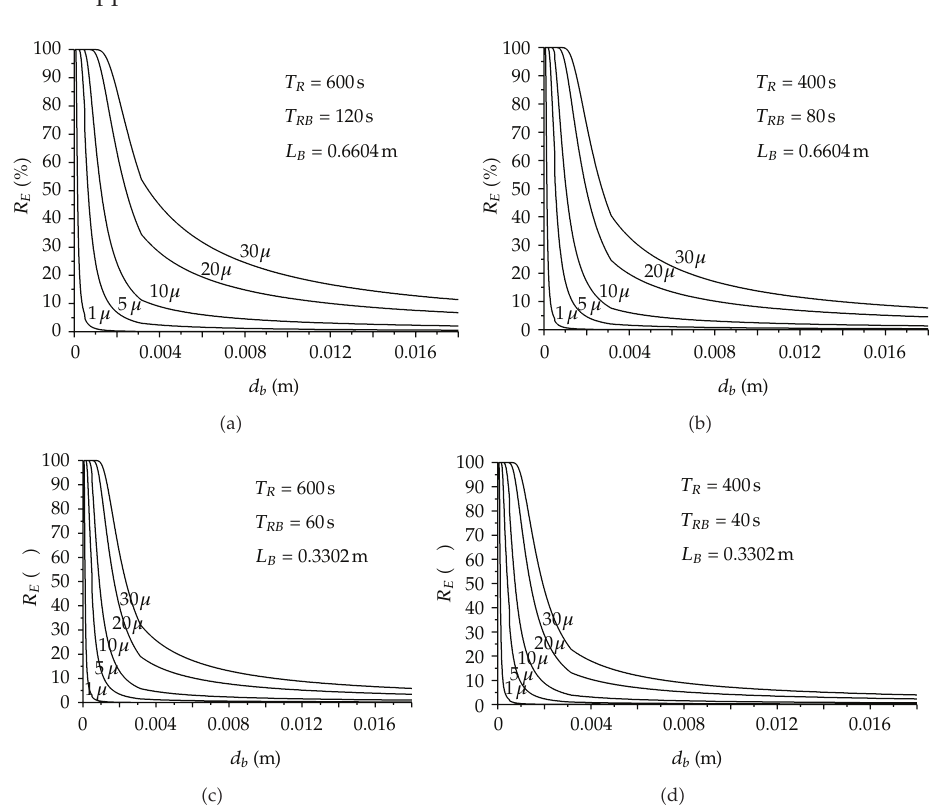
Figure 5: Prediction of the inclusion removal rate in a continuous casting tundish, (cid:4) a (cid:5) Constant T R and L B , (cid:4) b (cid:5) Decrease of T (cid:4) c (cid:5) Decrease of L (cid:4) d (cid:5) Decrease of T R in 200s, B by half, and R and decrease of L B by